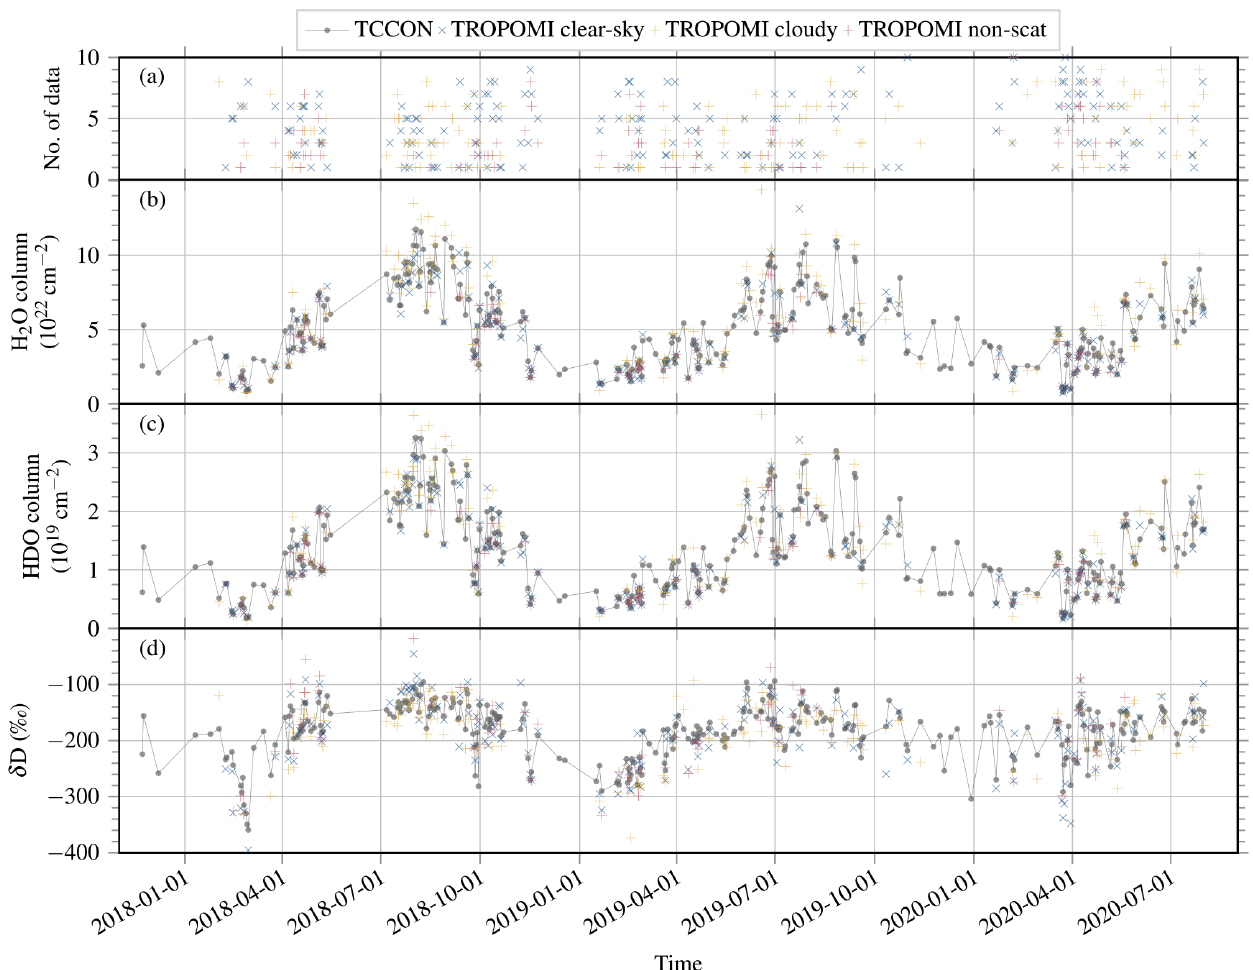
Figure 6. Time series of (a) individual observations per day, (b) daily medians of H 2 O columns, (c) HDO columns and (d) a posteriori δ D of TCCON (grey), TROPOMI clear-sky scenes (blue), TROPOMI cloudy scenes (yellow) and the former TROPOMI non-scattering retrieval (red) at Karlsruhe, Germany (49.1 ◦ N, 8.4 ◦ E,